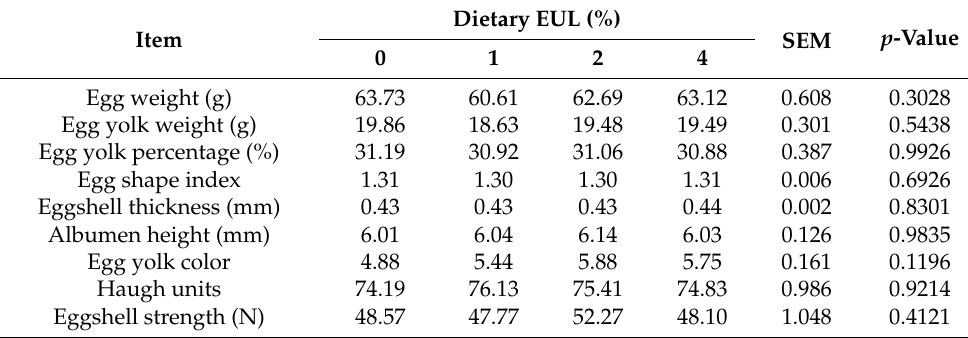
Table 4. Effect of dietary EUL on egg quality for laying ducks 1 .